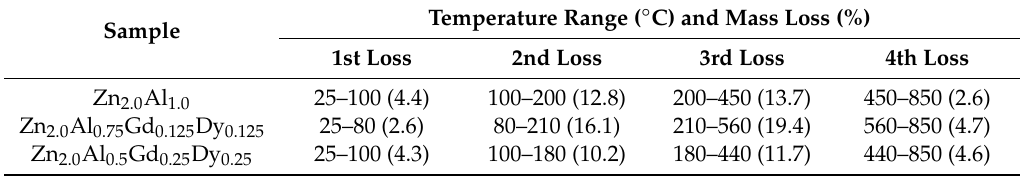
Figure 3. TGA curves of the LDH prepared. Table 5. TGA data of the sample LDH structures.